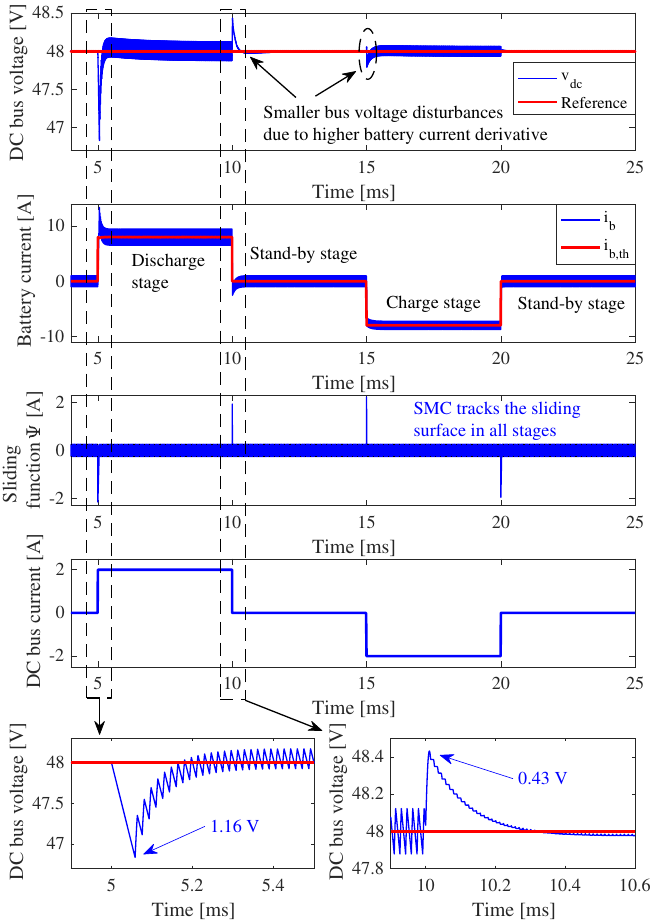
Figure 16. Simulation of the proposed SMC with perturbations in the bus